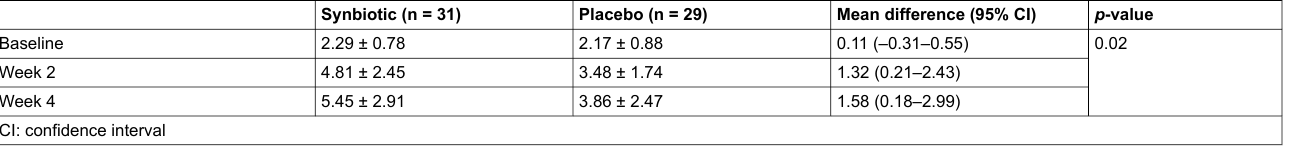
Table 3: Comparison of stool frequency per week between synbiotic and placebo groups. Data were expressed as mean ± standard deviation.